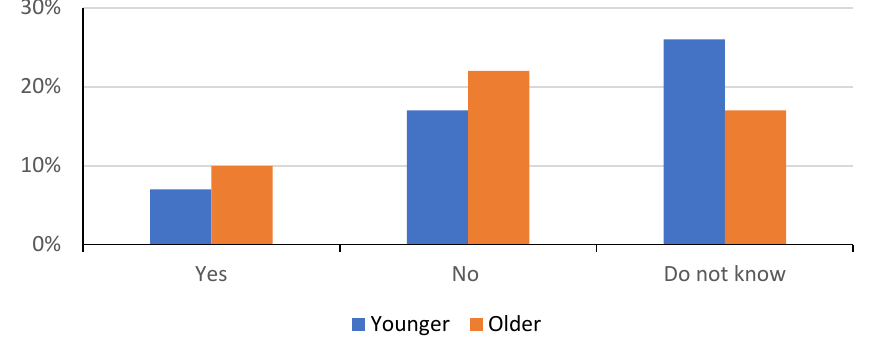
Figure 3. Respondent’s attitudes about anti-vaccination media headlines.